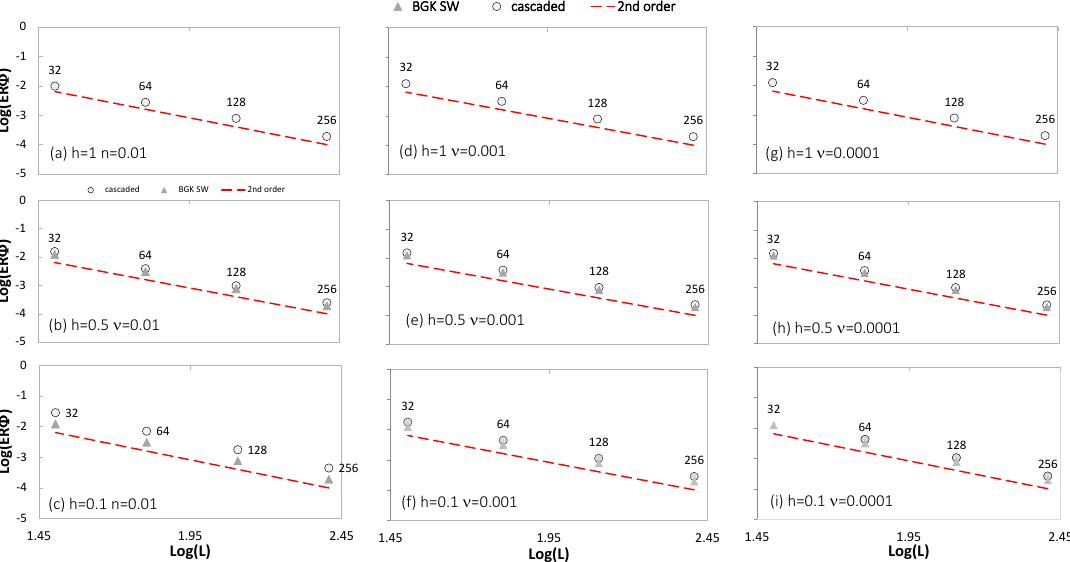
Figure A3. Taylor Green Vortex test. Slow velocity set—phase lag ER Φ , for the three depths: h = 1.0, h = 0.5, and h = 0.1 and three viscosities: ν = 0.01, 0.001, and 0.0001. The label shows the different values of the domain width L